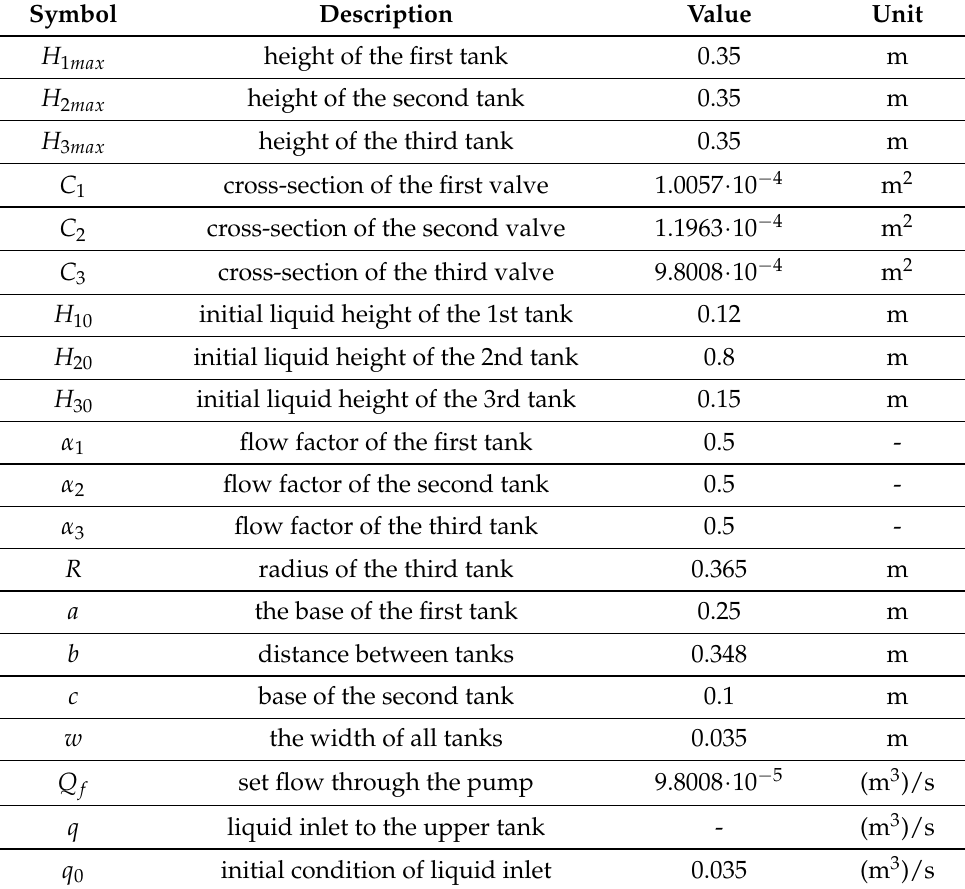
Table A1. The cascade multi-tank